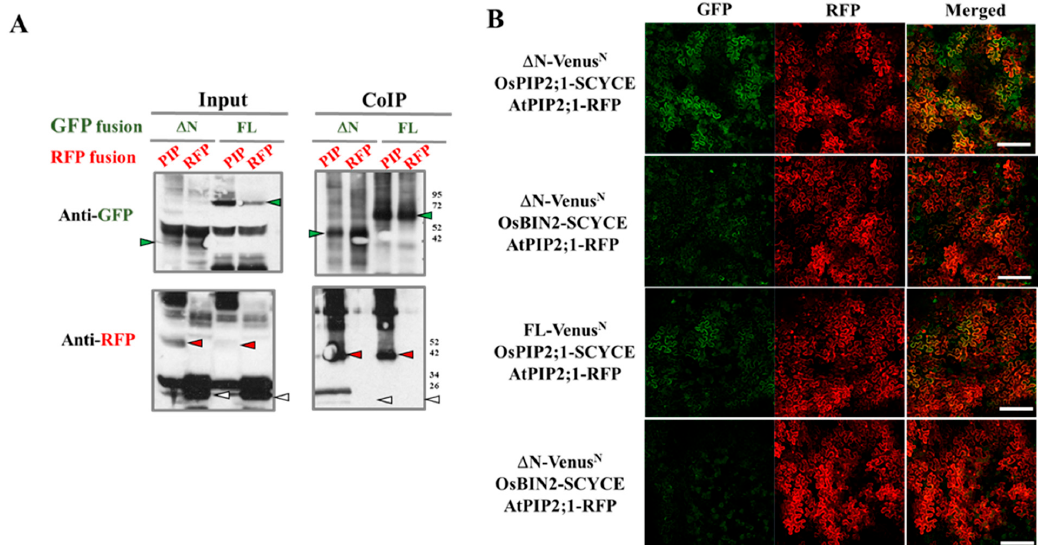
Figure 3. OsRLCK311 interacts with an aquaporin protein OsPIP2;1 in vivo. ( A ) Co-immunoprecipitation of Δ N or FL with OsPIP2;1 by transient expression in Nicotiana benthamiana and then identified by western blot. The proteins extracted from tobacco leaves infiltrated with both Δ N- GFP/FL-GFP (green arrows) and OsPIP2;1-RFP (red arrows) were co-immunoprecipitated (IP) with anti-GFP antibody and blotted with anti-GFP or anti-RFP antibody. Free RFP is marked in white arrows. ‘’Input’’ stands for protein extracts before immunoprepicitaton. ( B ) BiFC analysis of the interaction between Δ N or FL with OsPIP2;1 by transient expression in Nicotiana benthamiana . VenusN was fused at the C-terminus of Δ N and FL, while SCFPC was fused to the C-terminus of OsPIP2;1 and OsBIN2. Infiltration with OsBIN2-SCFPC were used as negative controls. AtPIP2;1-mcherry was used as a plasma membrane marker. Bar = 200 µM. 3.3. OsRLCK311 Negatively Regulates Stomata Response to ABA AtPIP2;1 knockout resulted in the loss of ABA-induced stomata closure [13]. In order to assess whether the OsRLCK311-AtPIP2;1 interaction led to the deactivation of AtPIP2;1-mediated stomata response to ABA, stomatal aperture was measured in epidermal peels of wild-type and transgenic plants over-expressing Δ N/FL. Over-expression of Δ N/FL significantly suppressed ABA-mediated stomatal closure (Figure 4). Notably, the expression of both OsRLCK311-FL and OsRLCK311- Δ N suppressed ABA-mediated stomatal closure, suggesting that the action of OsRLCK311 was independent of its kinase activity.